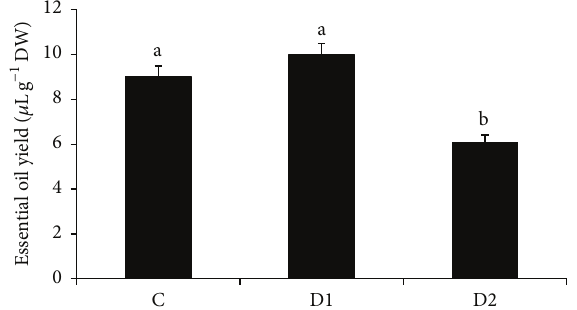
Figure 4: Effects of PEG levels (0, C; 2%, D1; and 4%, D2) on the oil yield of Thymus citriodorus